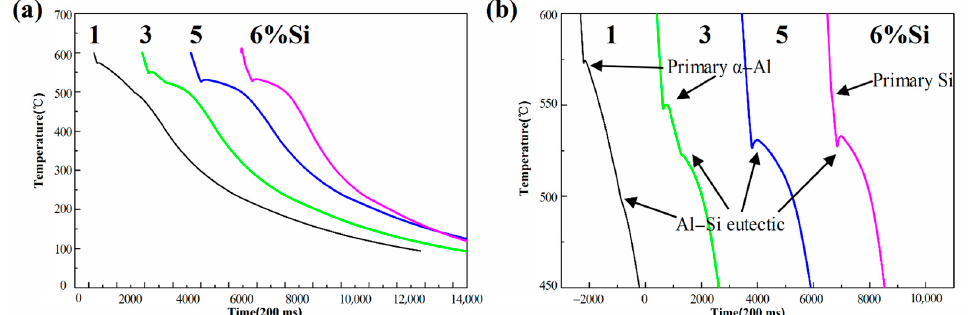
Figure 5. ( a ) Cooling curves of Al-40Zn-xSi alloys, ( b ) amplification of the reaction region of Al-Si eutectic in figure ( a ).